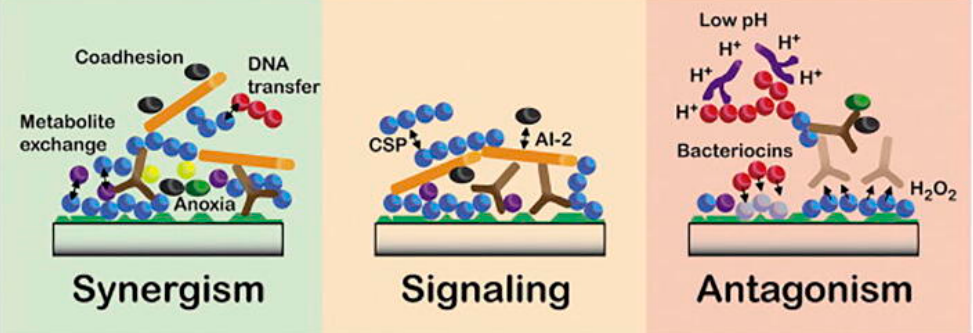
Figure 1. Main interspecies interactions entertained by oral microorganisms for the formation of oral biofilms. Those interactions can be categorized into synergism, signaling, or antagonism. Synergistic interactions are supported by the co ‐ adhesion of microorganisms to other microbes, which enhances multi ‐ species biofilm formation, promotes metabolite exchange, and modifies gene expression through DNA transferring processes, including bacterial conjugation, transformation, and transduction. Signaling interactions are primarily based on Autoinducer ‐ 2 (AI ‐ 2) and the competence ‐ stimulating peptide (CSP) quorum sensing systems, which influence several aspects of microorganisms’ behavior, including their growth, pathogenicity, and autolysis. Antagonistic interactions rely on: bacteriocins, or hydrogen peroxide (H 2 O 2 ) production and mechanism lowering microenvironment pH in order to inhibit the growth of specific microbes and gain a competitive advantage. Reproduced with permission. Radaic et al. [22] under Creative Common License.